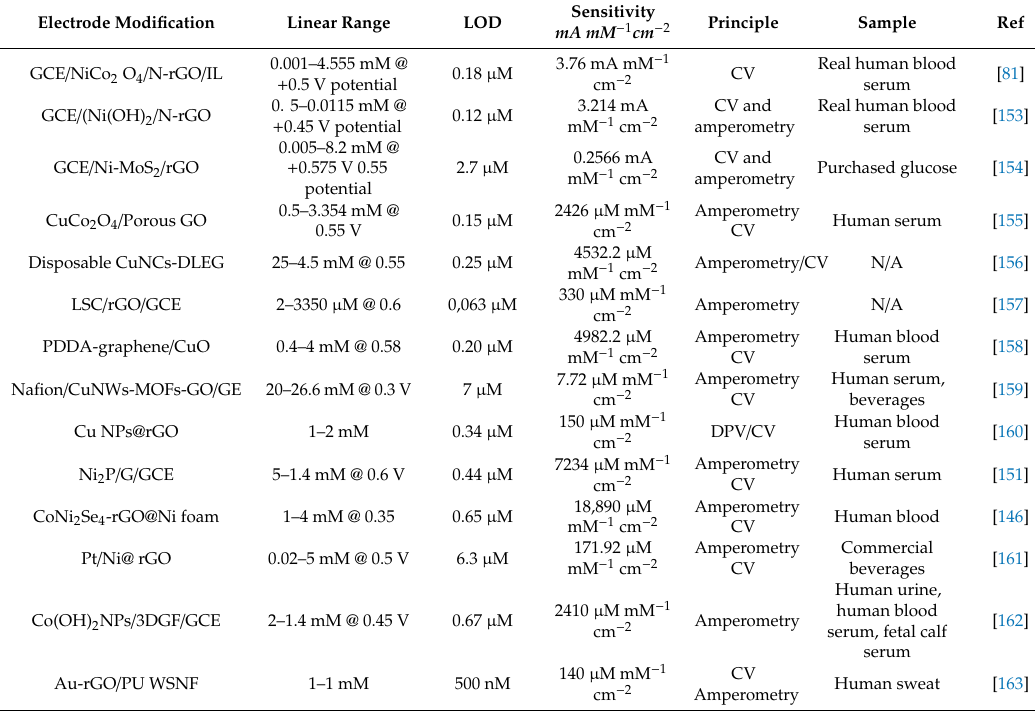
Table 3. Graphene-based electrodes for non-enzymatic glucose